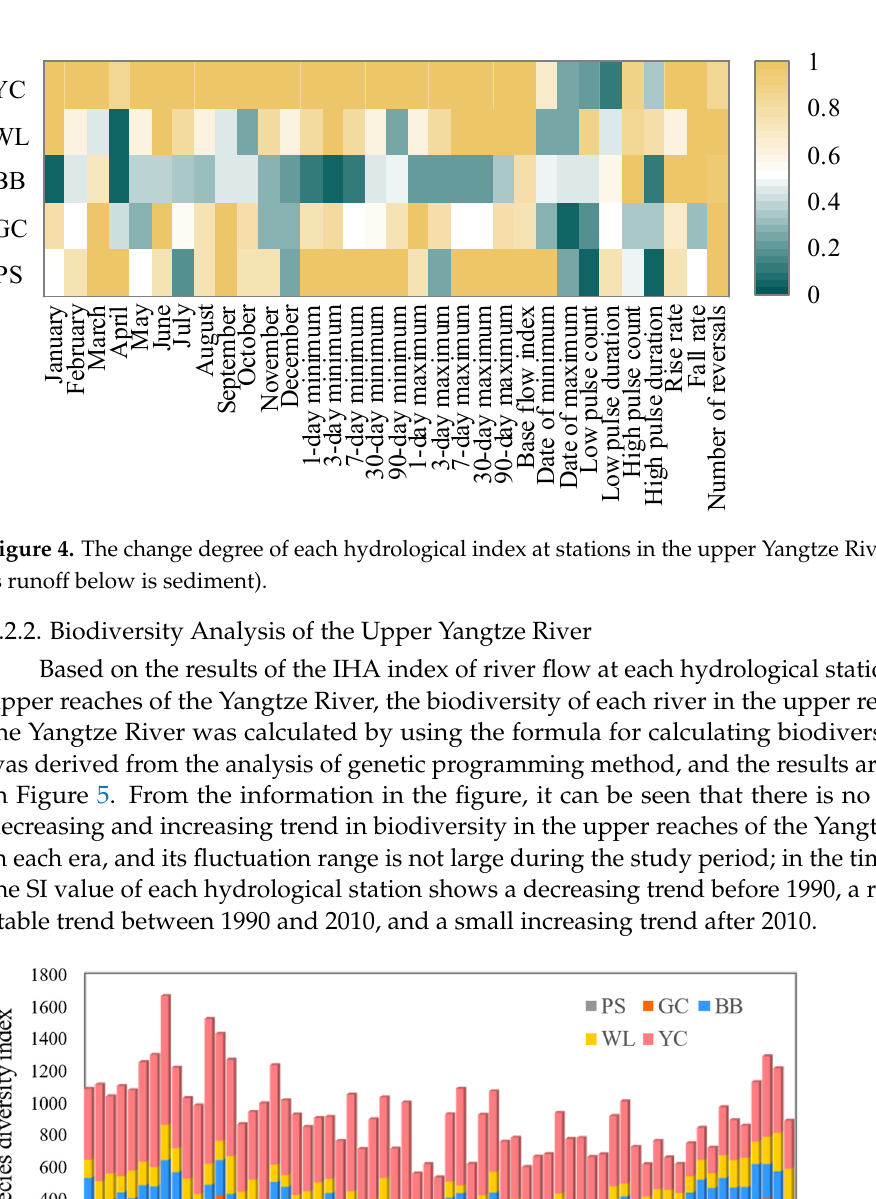
Figure 5. Fragrance diversity index in the upper reaches of the Yangtze River.